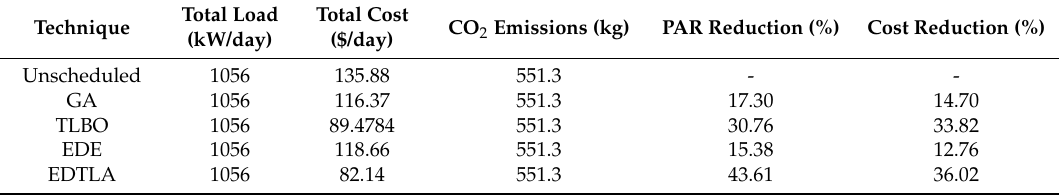
Table 3. Summarized results of CO 2 , peak to average ratio (PAR) and cost reduction.